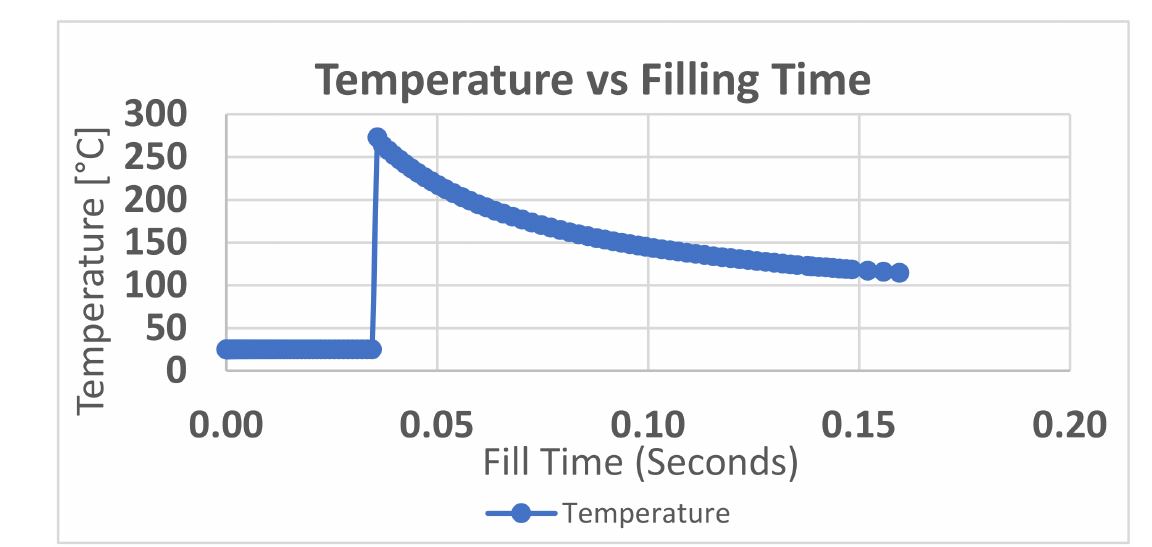
Figure 16. Temperature vs. fill time at SNF1 on M5 core pin from Moldex3D; the temperature of the pin suddenly increases as the molten polymer touches it and it starts to gradually cool over the injection cycle.